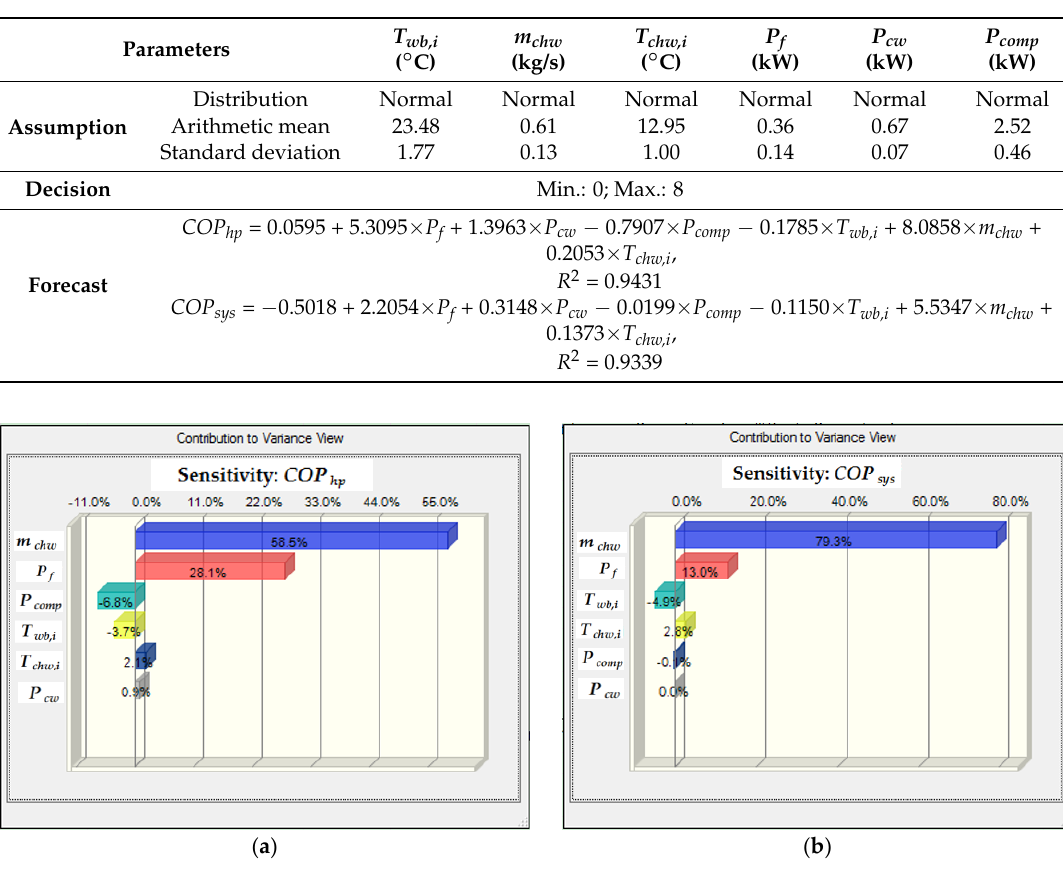
Table 4. The assumption, decision and forecast of Crystal Ball.